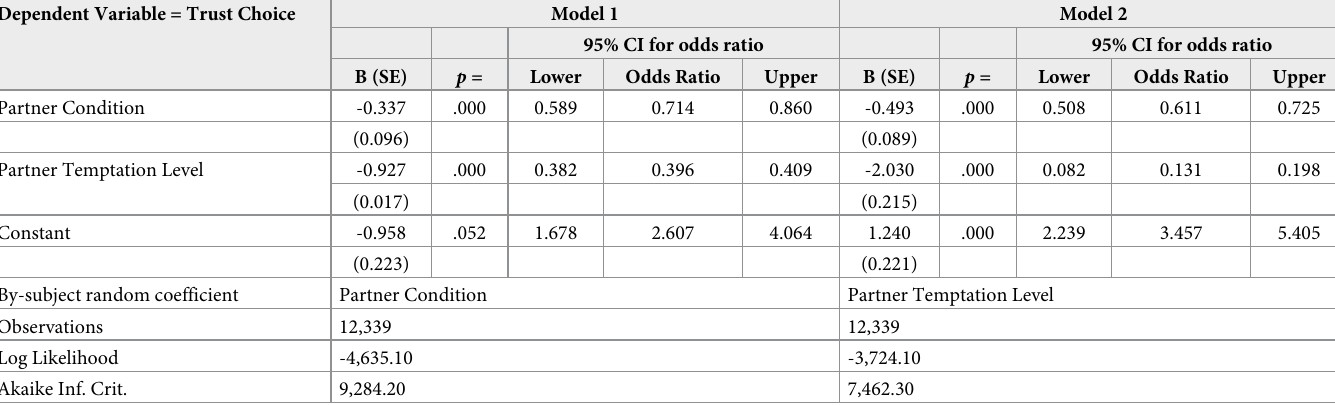
Table 3. Analysis results from Experiment 2 using mixed-effects logistic regressions of partner condition and partner temptation level on participants’ choices. Regression models are identical to those used in Experiment 1. Again, Model 1 and Model 2 are used for inferring the effects of partner condition and temptation level, respectively, on trust rates, given the inclusion of their corresponding by-subject random